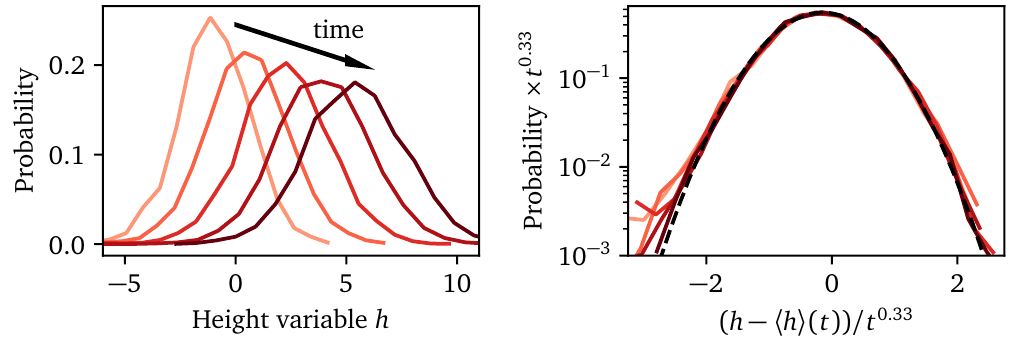
Figure 7: Self-similarity in the run-to-run fluctuations of the OTOC. Time depen- dent probability distribution of the height variable h ( t ) defined in the main text at G = 61.44, near the phase transition. All curves collapse after a rescaling with t α , 0.06 . The scaling function is close to a Gaussian (dashed black line), α = 0.33 ± with residual deviations from scaling and Gaussianity vanishing as time